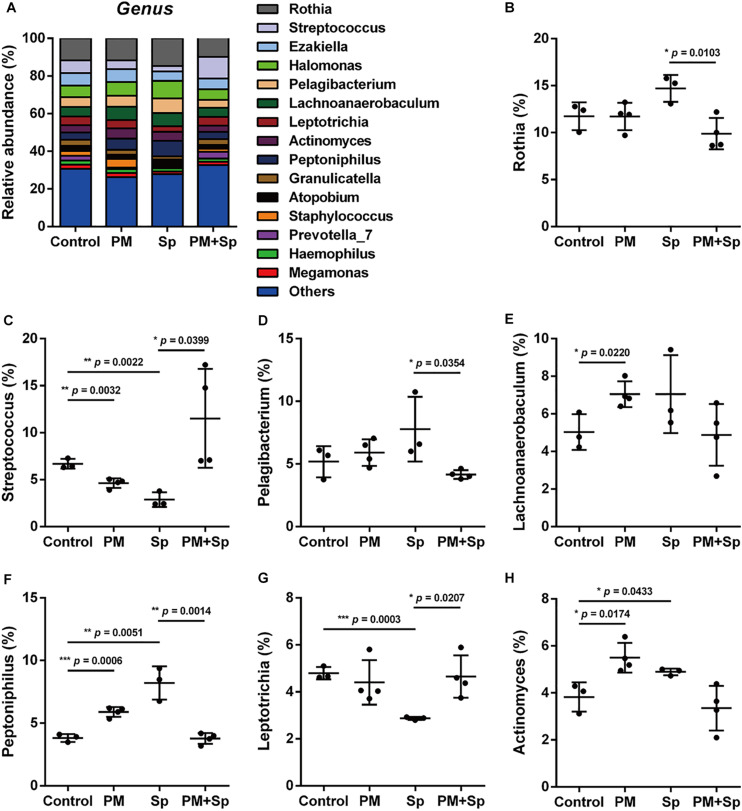
Relative abundance of bacterial genera in mice treated with PM2.5 and pneumococcus. The bacteria taxonomic profiles at the genus level in BALF microbiome from PM2.5-treated (PM) and/or pneumococcus-infected (Sp) mice. (A) The top 15 most abundant genera among four groups were shown. Relative abundances of (B)
Rothia, (C)
Streptococcus, (D)
Pelagibacterium, (E)
Lachnoanaerobaculum, (F)
Peptoniphilus, (G)
Leptotrichia, and (H)
Actinomyces in BALF microbiota community were analyzed. Student’s t-test was used to analyze the statistical significance of the experimental results between two groups. *P < 0.05; **P < 0.01; ***P < 0.001.